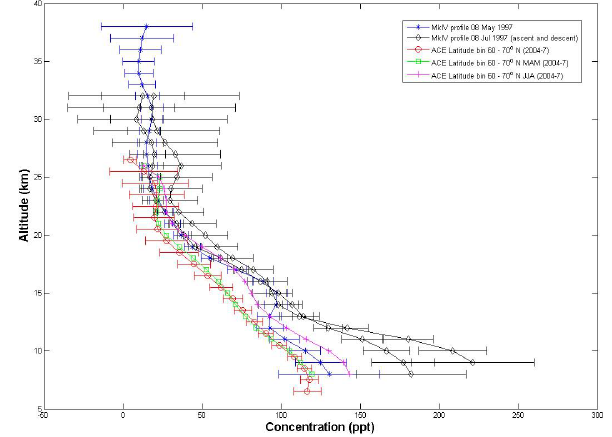
Fig. 6. The average carbon tetrachloride volume mixing ratio profile for the latitude bin covering 60–70 ◦ N (red line with circles) from the ACE mission between February 2004 and August 2007. The av- erage profile is compared with three balloon profiles obtained using the MkIV FTS instrument launched from Fairbanks, Alaska (64– 70 ◦ N) on the 8 May 1997 (blue line with asterisks) and 8 July 1997 (ascent and descent both black lines with diamonds) obtained by Toon et al. (1999). The average profile, covering the same latitudes for the whole mission period, for the MAM (March-April-May) and JJA (June-July-August) seasons are also included (green line with squares and magenta line with pluses